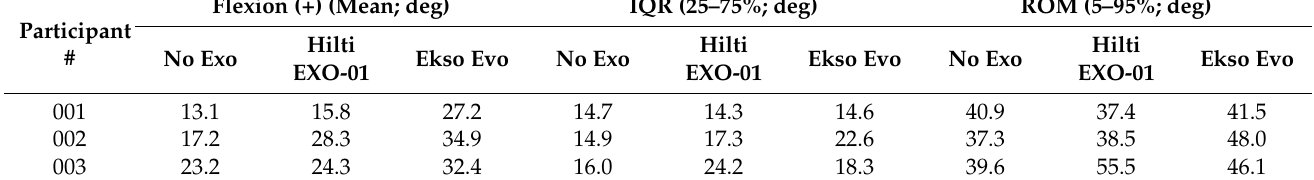
Table 9. Abduction/adduction (deg) of the left shoulder.